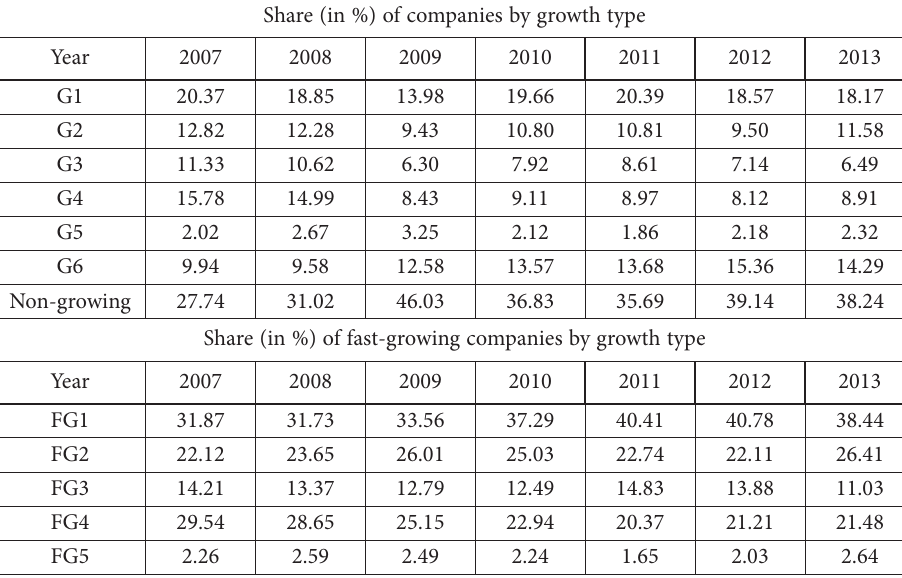
Table 1. Structure of firms according to growth type (source: authors’ own computations based on the APLR data) Share (in %) of companies by growth